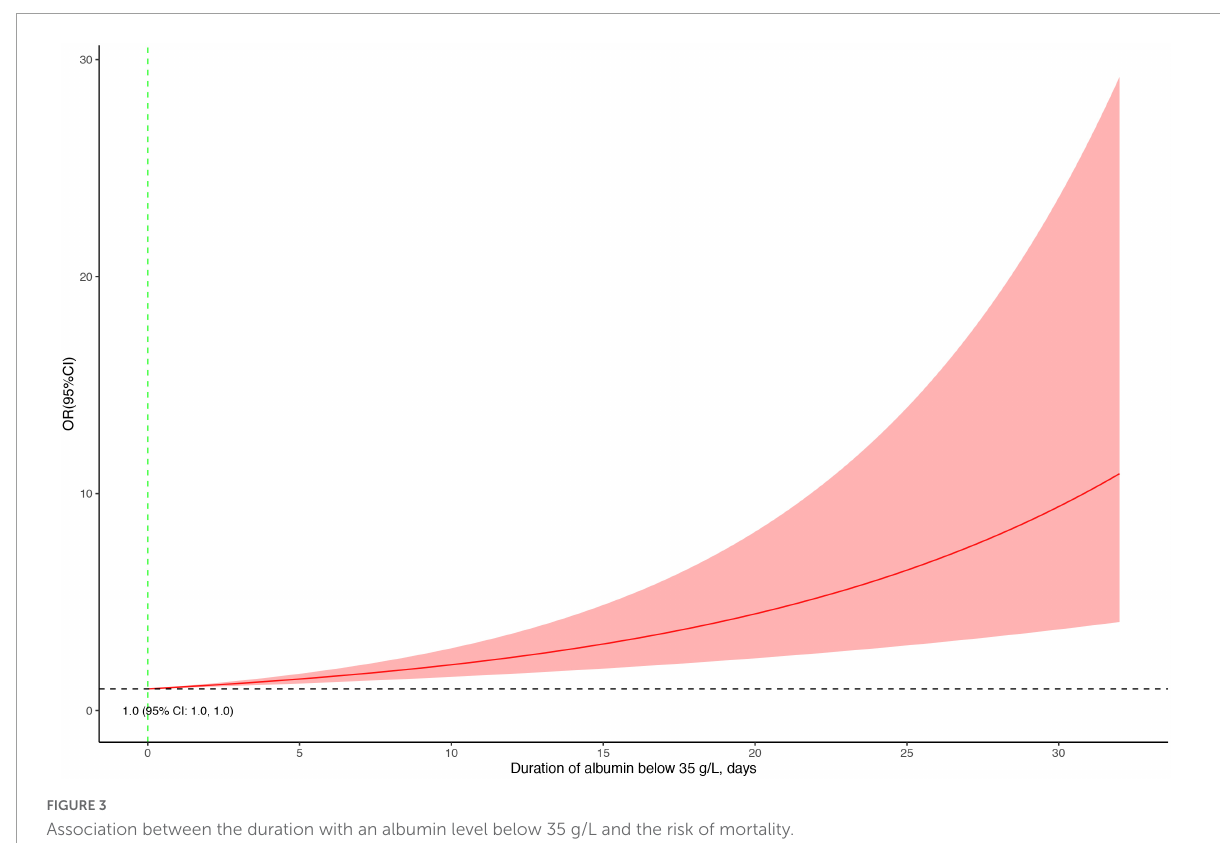
FIGURE3 Association between the duration with an albumin level below 35 g/L and the risk of mortality.